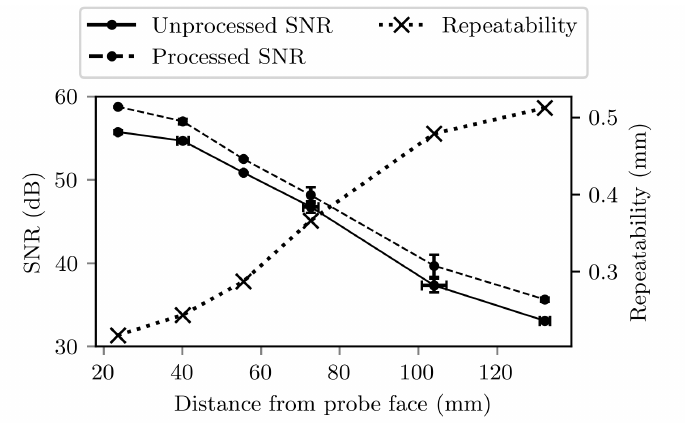
Figure 13. Signal-to-noise ratio and tracking repeatability magnitude measured at six depths in the bovine tissue phantom. Depths were determined using the UNT system. Vertical error bars show standard deviations of three repeat measurements of signal-to-noise ratio. Horizontal error bars on the unprocessed signal-to-noise ratios shown standard deviations in the depth measurement across the three repeats, and are applicable to all three plotted